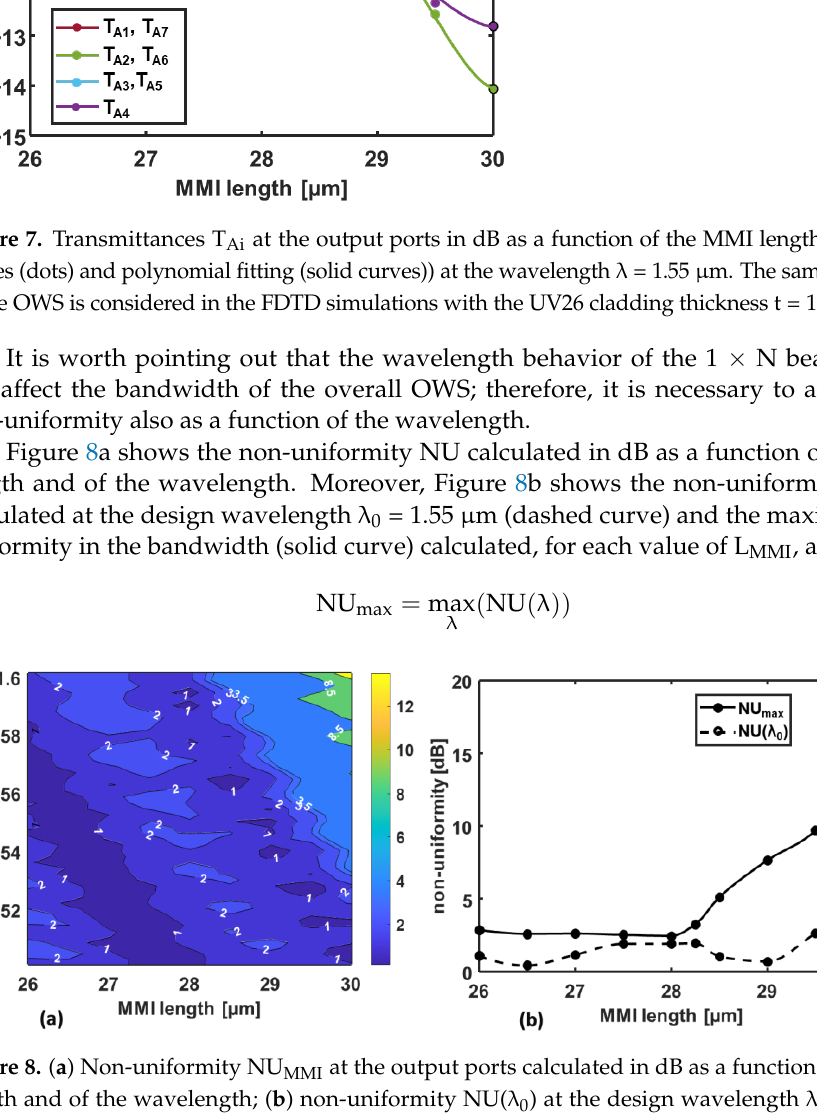
Figure 7. Transmittances T Ai at the output ports in dB as a function of the MMI length (calculated values (dots) and polynomial fitting (solid curves)) at the wavelength λ = 1.55 μm. The same multi-